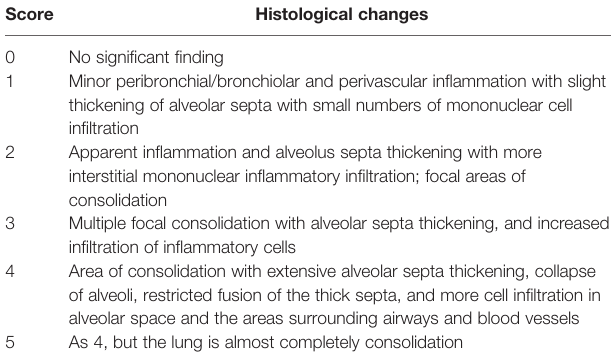
TABLE 2 | Histological Scoring